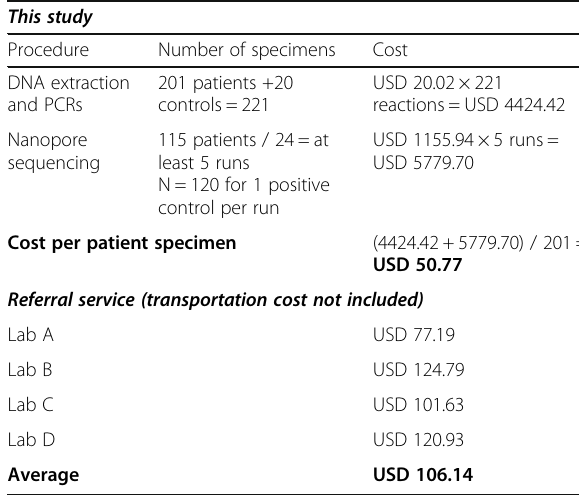
Table 9 Comparison of estimated reagent cost of Nanopore workflow (24-plex) and randomly-selected prices of HPV genotyping referral service in Hong